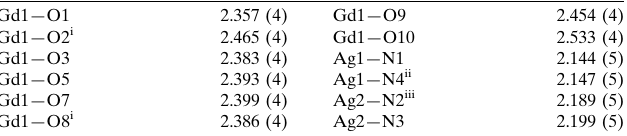
Selected bond lengths (A˚ ).